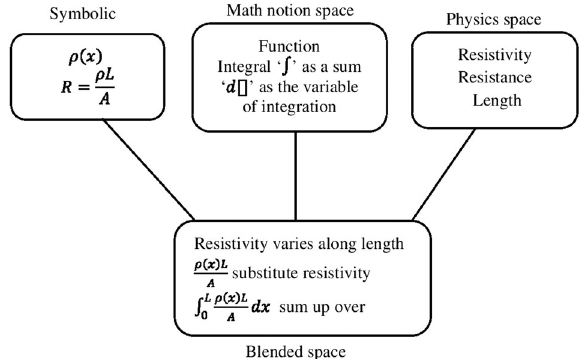
FIG. 3. Example of a blending diagram from the work of Hu and Rebello